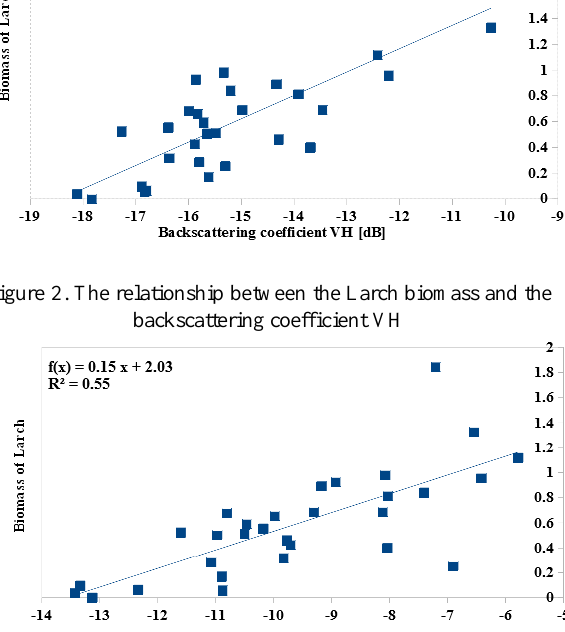
Figure 3. The relationship between the Larch biomass and the backscattering coefficient